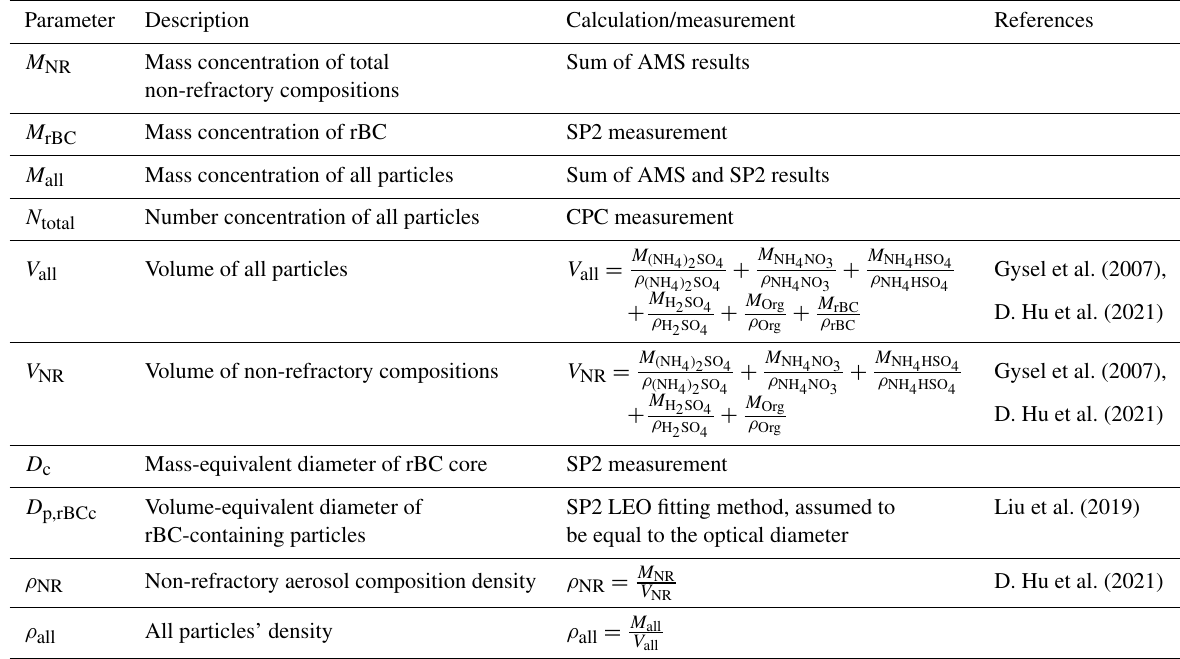
Table A1. Parameters used for the calculation of size-resolved shape factors. Parameter Description